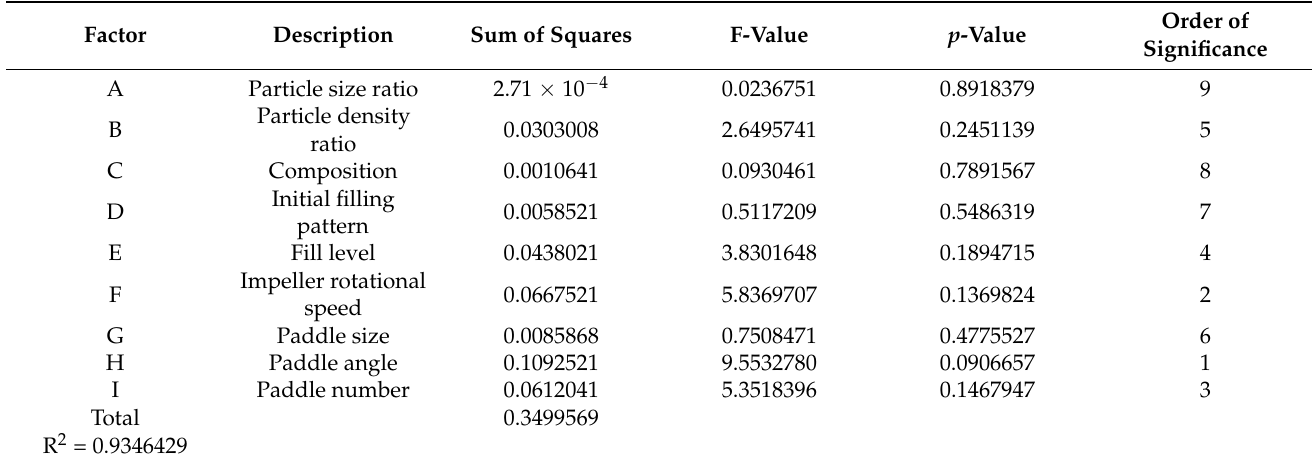
Table 6. Analysis of variance (ANOVA) results of KPI 1 mixing quality.